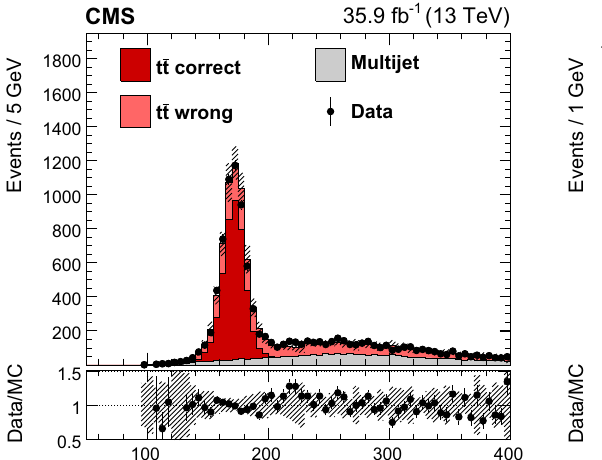
assignments and displayed separately, and the distributions are normal- ized to the integrated luminosity. For the background estimate, the total normalization is given by the difference of observed data events and expected signal events. The hashed bands represent the total uncer- tainty in the prediction. The lower panels show the ratio of data and prediction